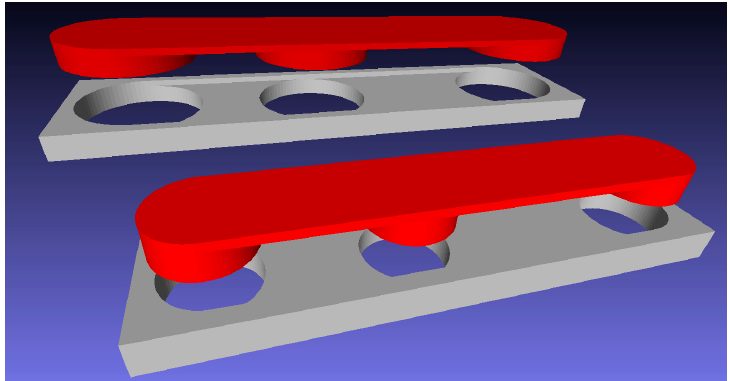
Figure 3. Exploded view of 3D printer capacitive markers with no insulation layer, i.e., the pads (or “bridge piers”) have direct contact to the touch screen surface below. The 5 mm pad diameter is shown in front and 10 mm pad diameter in the back. In this CAD view, the insulating parts are colored grey, conductive ones (“bridges”) red.